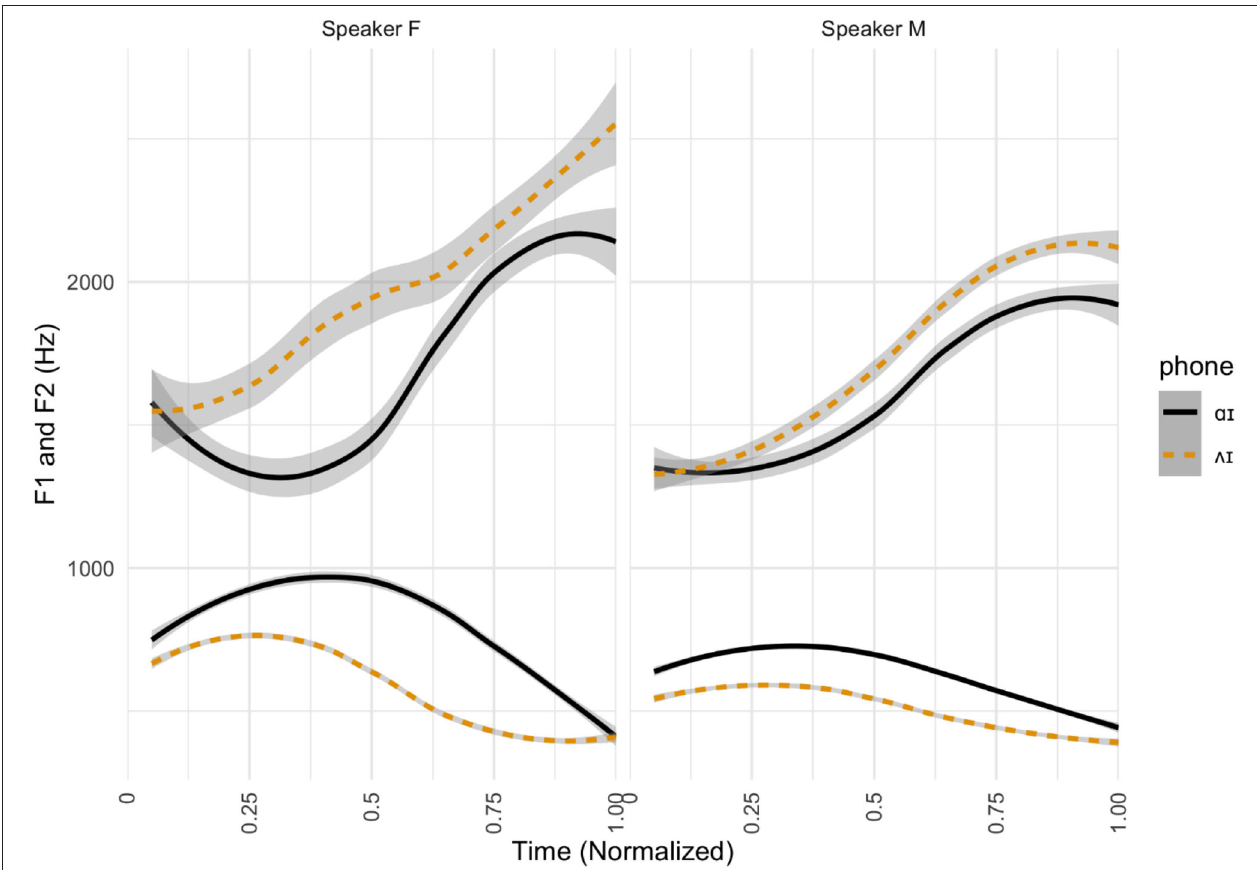
FIGURE 8 | Formant contours for writer-rider stimuli. Time-normalized formant contours (F1 and F2) in Hz for the two speakers providing perception stimuli, separated by target phone. Formants for rider -words are shown in black and formants for writer -words in